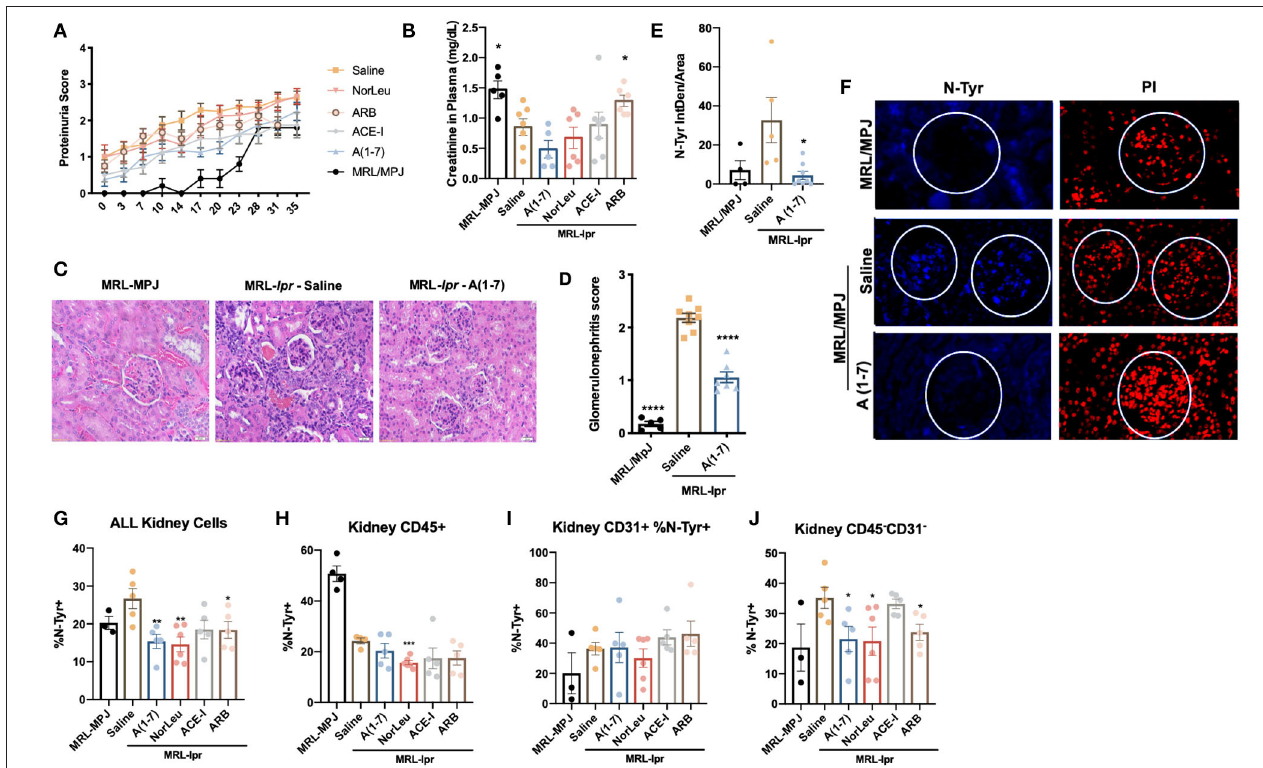
FIGURE 6 | RAS-modulation, especially A(1-7) treatment, improves kidney health. (A) Protein scores were taken every 3–4 days throughout the study duration, scores were: 0, none; 1, trace; 2, > 30 mg/dl; 3, > 100 mg/dl. (B) At necropsy, plasma was collected and creatinine levels were measured. (B) Kidney samples from both MRL-Mpj and MRL- Ipr mice where stained using H&E, photos were taken at x20 magnification. (C) Twenty glomeruli from each kidney were scored as follows: 0, no glomerular lesions; 1, minimal thickening of mesangium; 2, noticeable increase in both mesangial and glomerular capillary cellularity; 3, presence of preceding conditions along with superimpose inflammatory exudate and capsular adhesion; 4, obliteration of the glomerular architecture included > 70% of glomeruli. (D) Paraffin-embedded kidney sections were stained with anti-N-Tyr-Ab(blue) and counterstained with PI (red) antibodies to measure oxidative stress. (E) Photos were taken at x20 magnification using Echo Revolve microscope and the intensity inside the glomerulus was measured using Image (F) , and corrected to total area of the glomerulus; each data point represents one animal and the average from 20 glomeruli per animal. At necropsy kidneys we dissociated and stained with anti-N-Tyr-Ab (All, G ) intercellularly and extracellularly for immune cells (CD45 + , H ), endothelial (CD31 + , I ) and kidney (CD45 − CD31 − , J ). Statistics were run using Prism 8.4.0, t -tests were used to compare all groups to saline treated MRL -lpr mice; * p ≤ 0.05, ** p ≤ 0.01, *** p ≤ 0.001, **** p ≤ 0.0001.